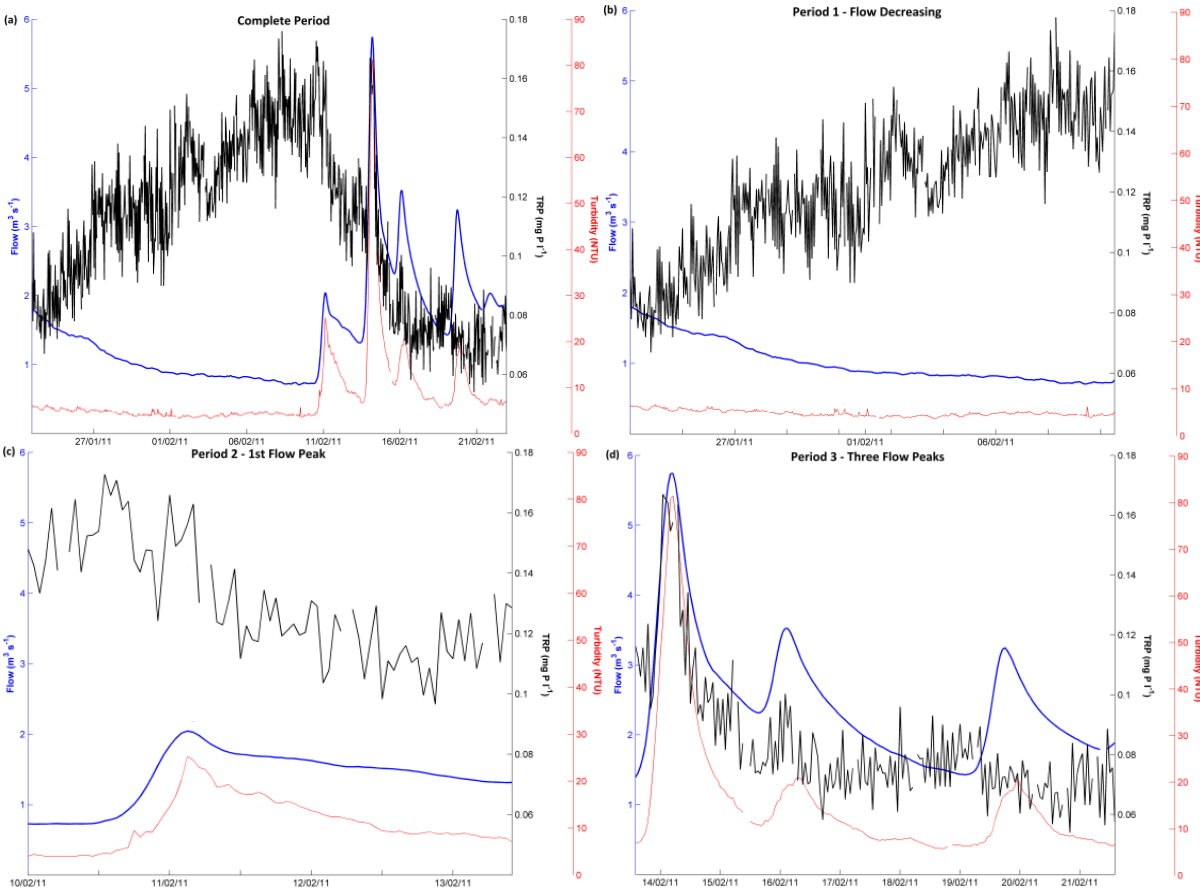
Fig. 7. Streamwater phosphorus dynamics in the River Enborne for a one-month period between January and February 2011. The figure illustrates the complexity of the TRP response to flow events for (a) the period January to February 2011. Panel (b) demonstrates that streamwater TRP can increase as flow decreases during this period. Panel (c) demonstrates an initial dilution of the streamwater TRP followed by a subsequent increase with a peak in flow. Panel (d) illustrates how the streamwater TRP concentration can increase and then decrease with subsequent peaks in